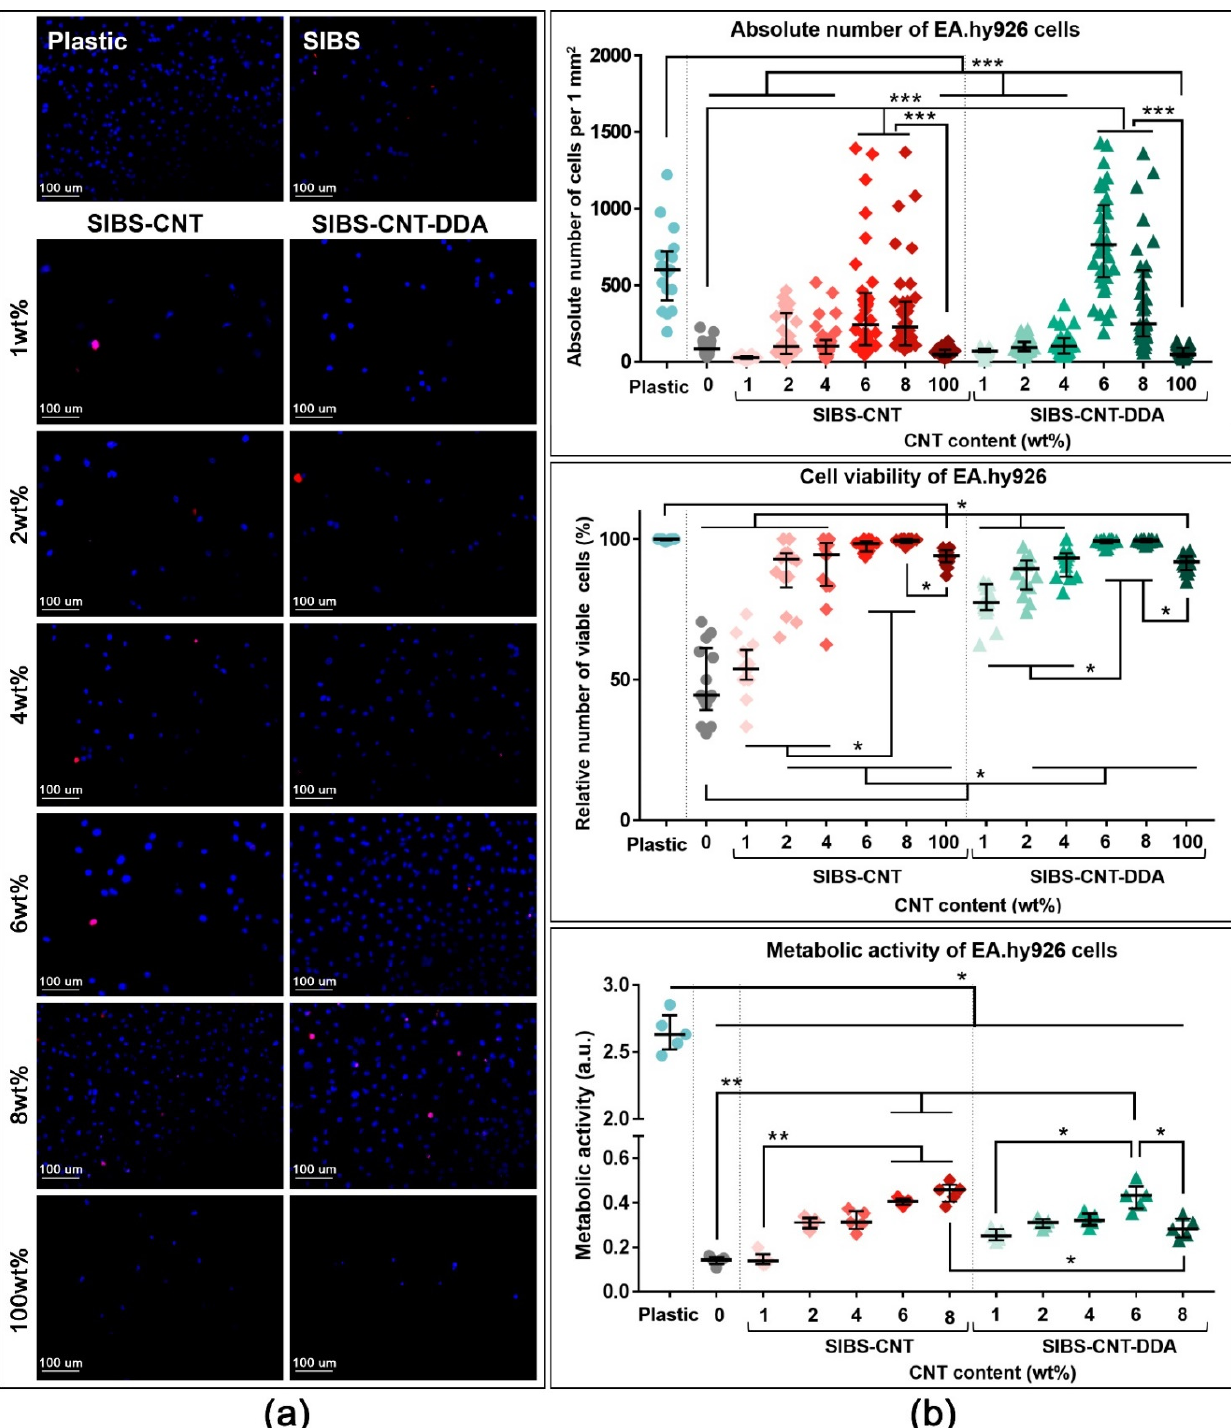
Figure 8. Cytotoxicity studies of nanocomposites using endothelial cells Ea.hy926. The fluorescent microscope images of the films after cell cultivation, ×200 magnification ( a ). Total cell count, viability and metabolic activity of cells cultured on the surface of the nanocomposites are presented depending on CNT concentration ( b ). One asterisk (*) signifies a p value equal to or smaller than 0.05 ( p ≤ 0.05); Two asterisks (**) signify a p value equal to or smaller than 0.01 ( p ≤ 0.01); Three asterisks (***) indicate p value equal/smaller than 0.001 ( p ≤ 0.001) The metabolic activity of cells on the samples containing 6 and 8 wt% CNTs and CNT-DDA is higher ( p < 0.05) compared to 0 and 1 wt% in the corresponding group